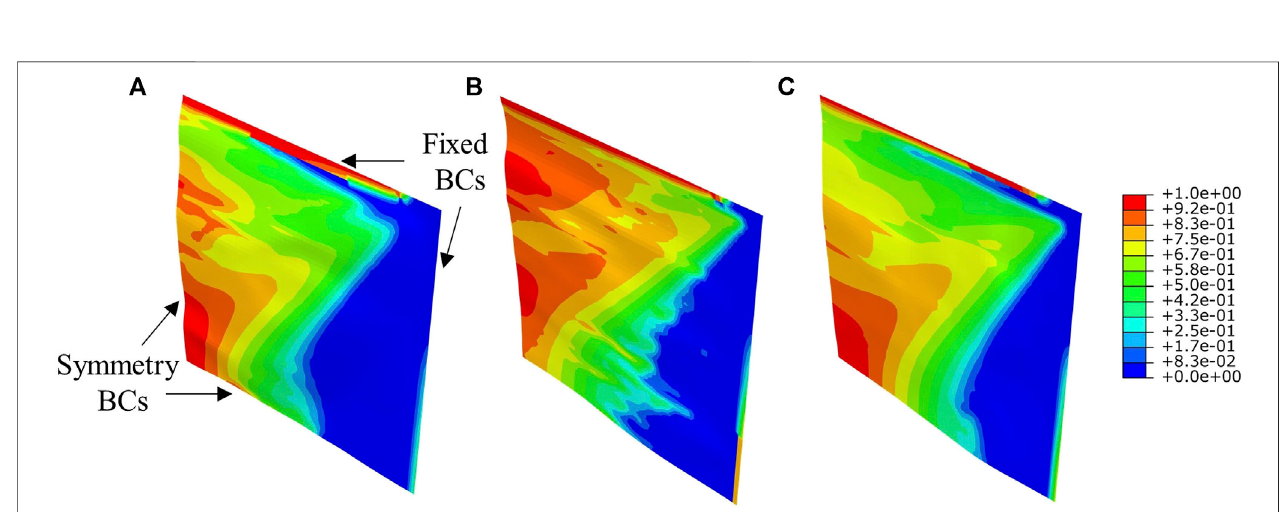
FIGURE9| Matrixtensiondamage ofthecomposite layer under the impulsive load of Z (cid:2) 1 . 82 m / kg 1 / 3 . (A) 0 . 31 / 0 . 18 [ 0 ° ] / 0 . 31plate. (B) 0 . 22 / 0 . 36 [ 0 ° / 0 ° ] / 0 . 22